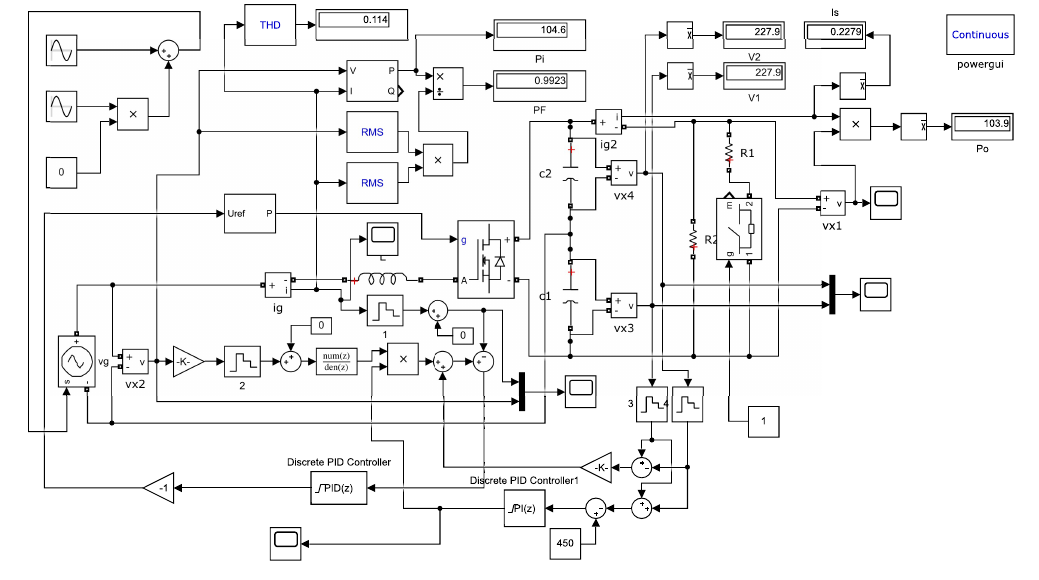
Figure 15. Simulation scheme for CV3.